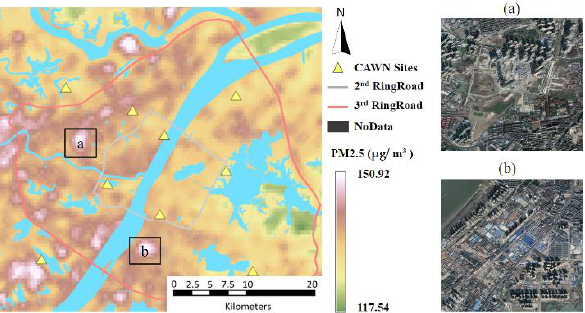
Figure 5. The ground truth of Wangjiadun region (a) and Baishazhou region (b) in Google Earth